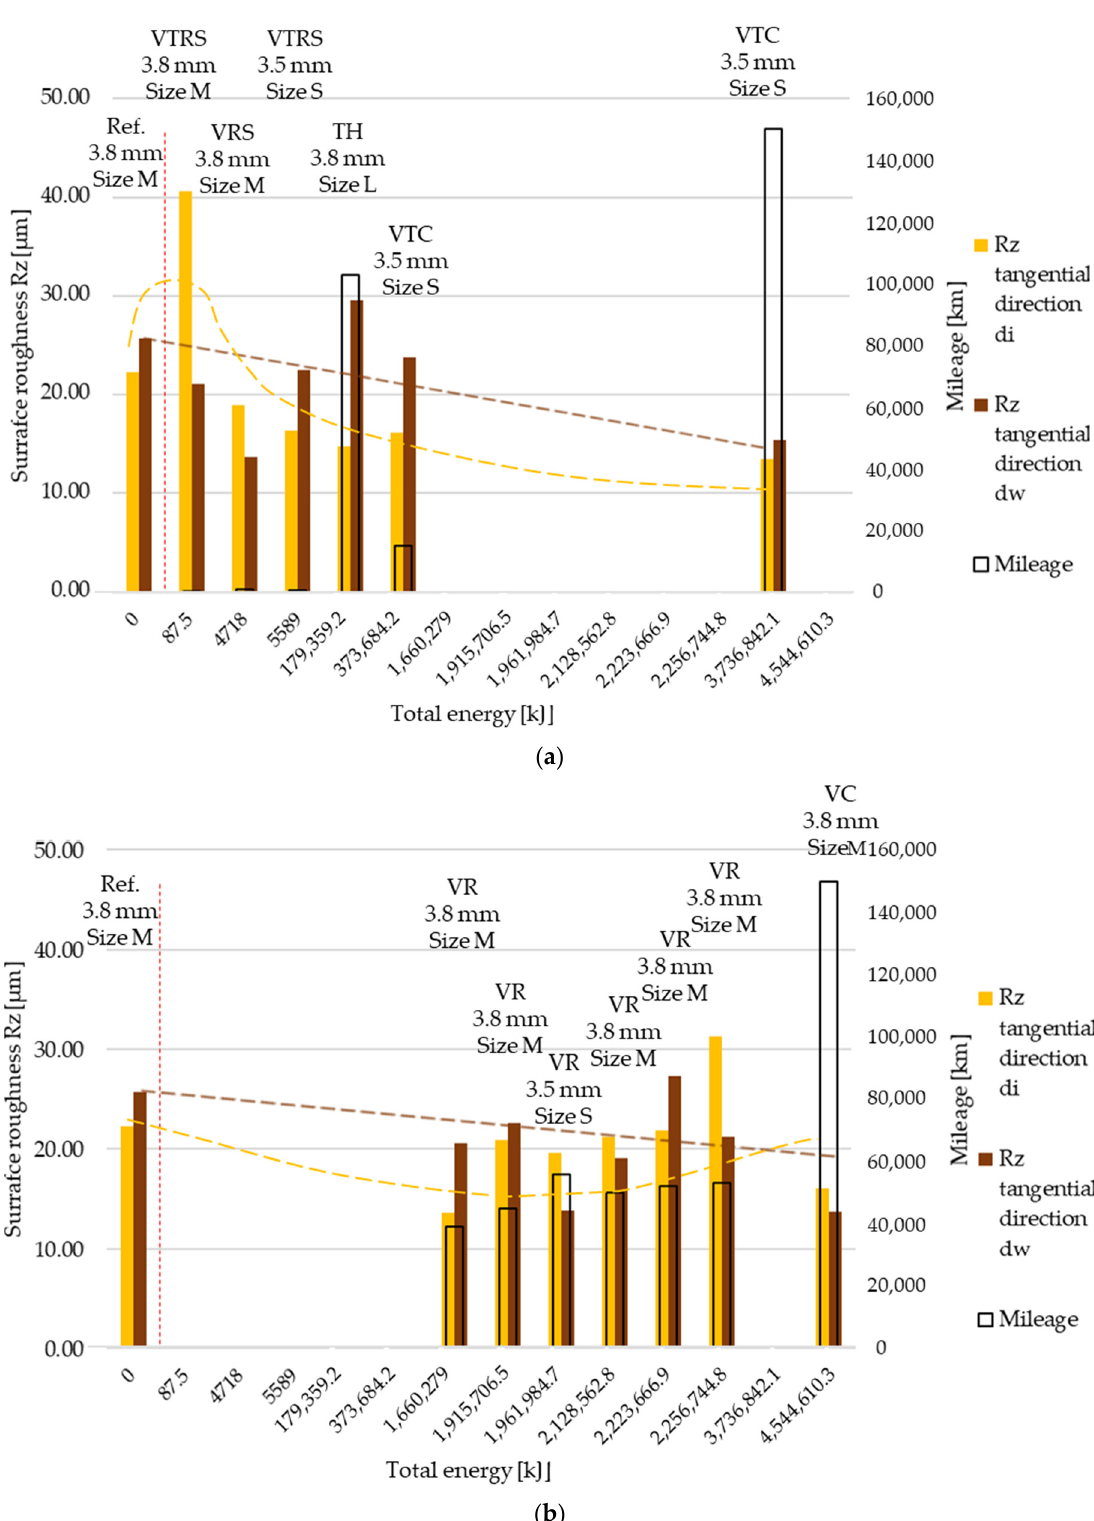
Figure 8. ( a ) Rz surface roughness values, tangential direction–trend 1: clutch killer tests. ( b ) Rz surface roughness values, tangential direction–trend 2: moderate tests.